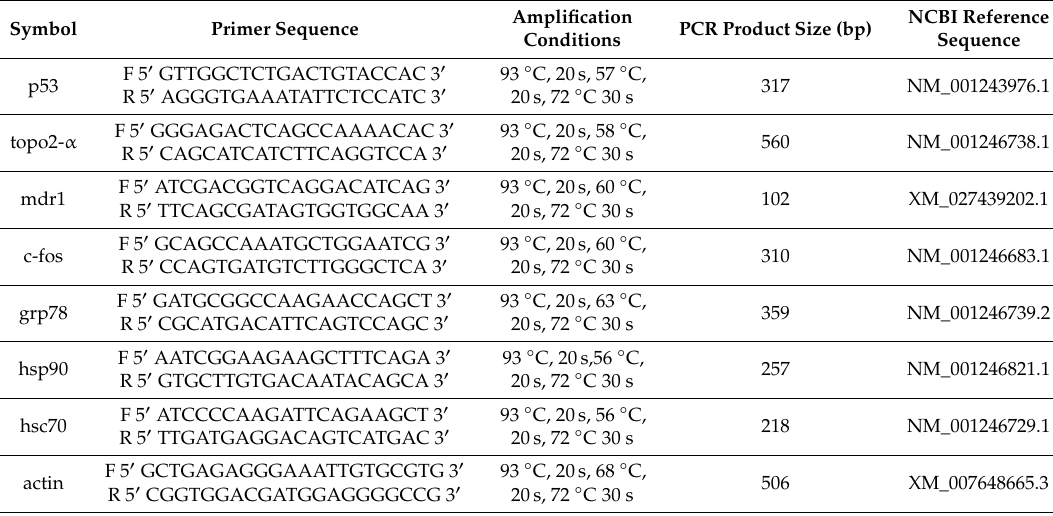
Table 1. The primers and conditions for